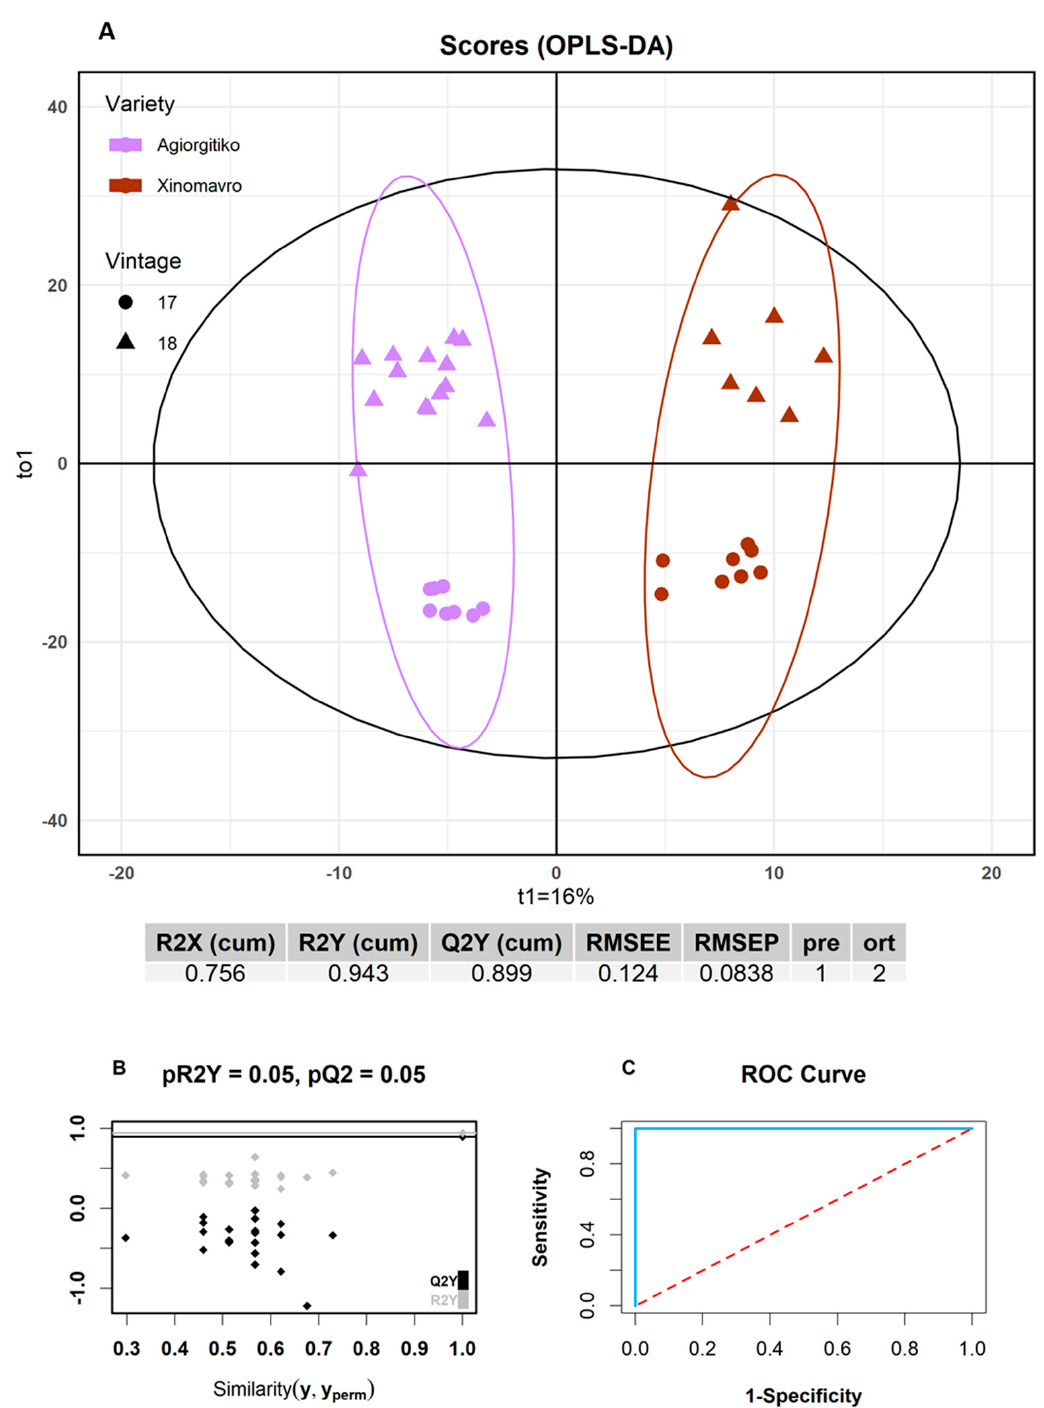
Figure 4. ( A ) Score plot of the OPLS-DA model for the discrimination of Agiorgitiko and Xinomavro wines based on grape varieties. The number of components and the cumulative R 2 X, R 2 Y and Q 2 Y and RMSEE, RMSEP values are presented below the plot; ( B ) Permutation test: Plot depicting the comparison of the cumulative R 2 Y and Q 2 values of the model compared with the corresponding values obtained after random permutation of the y response; ( C ) Receiver Operating Characteristics (ROC) curve for the developed OPLS-DA model.